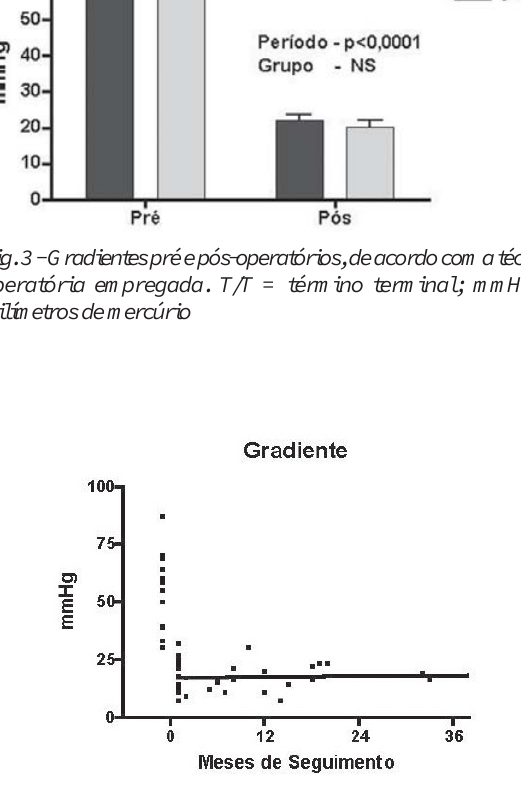
Fig. 4 - Evolução dos gradientes pós-operatórios ao longo do período de